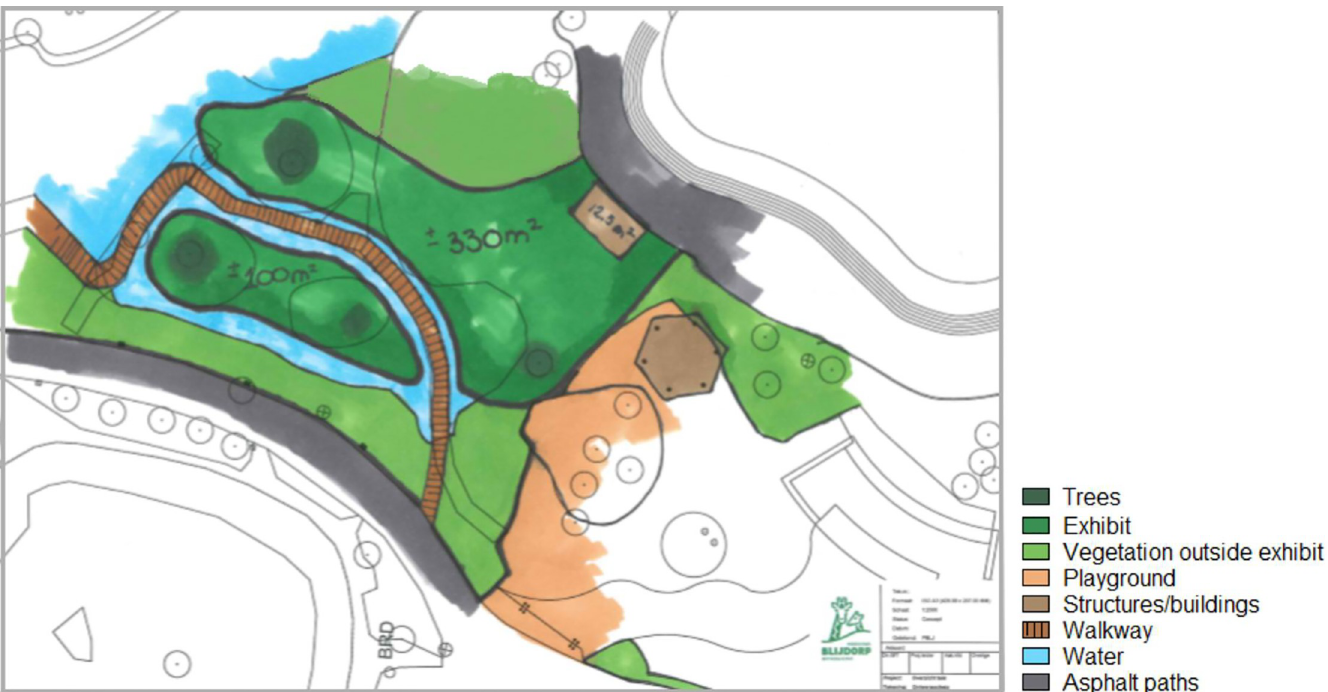
Fig 2. A ground plan depicting the red panda enclosure in Rotterdam Zoo. The 330m 2 part is shared with the Michie’s Tufted Deer.